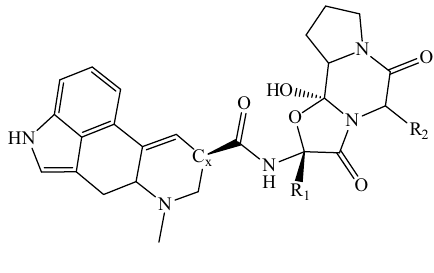
Figure 1. Basic structure of the ergotalkaloid. Correct substitution of R ergopeptides ergocornine and α -ergocryptine (see Figure 2).